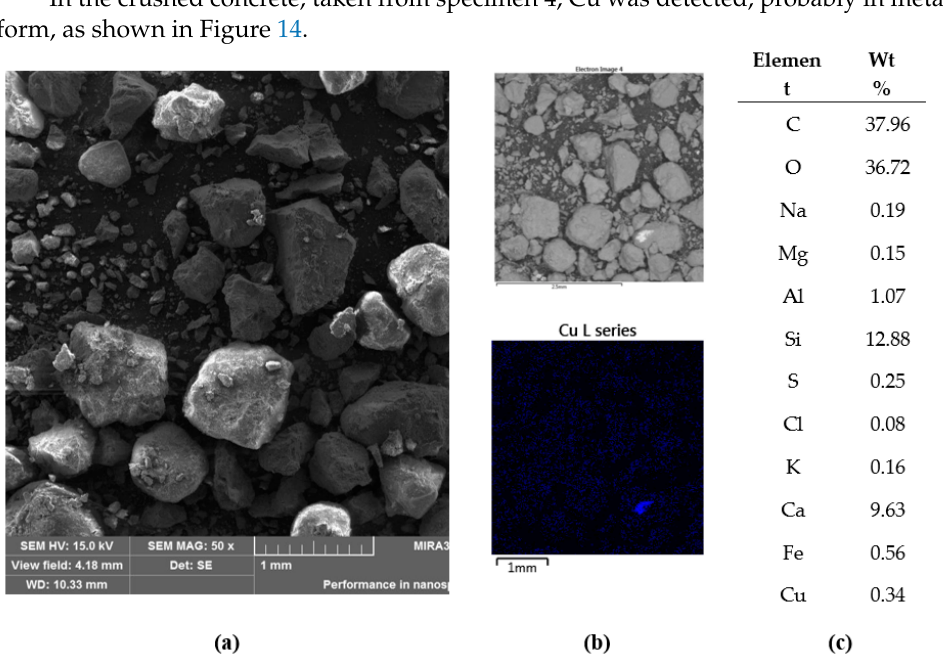
Figure 15. Crushed concrete on carbon tape, specimen 4: Si, Ca, Al, Mg, and Na maps over the analyzed area shown in Figure 14b. Mg is evenly distributed throughout the image, suggesting it is absorbed freely.